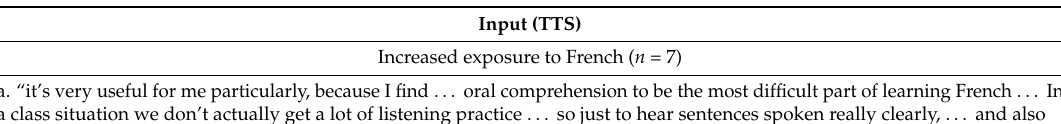
Table 4. Learners’ perceptions of TTS and ASR according to the tools’ ability to increase/enhance the input, and create opportunities for output practice and for the development of prediction skills